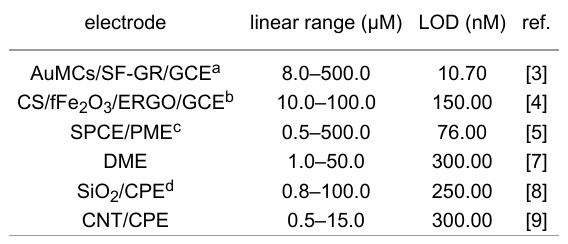
Table 1: Comparative results of GA detection on various electrodes.